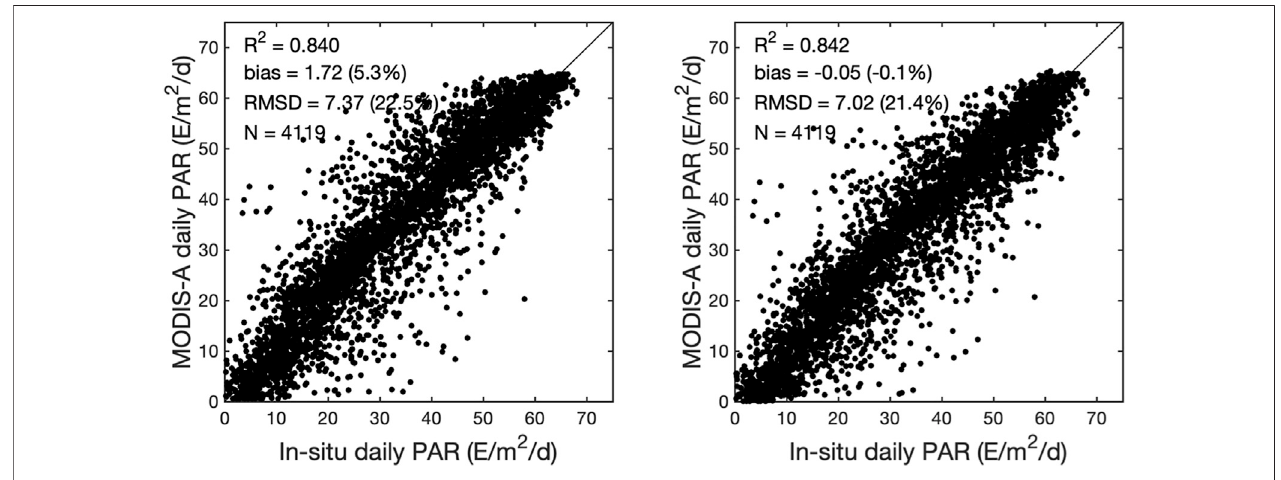
Frontiers in Remote Sensing |